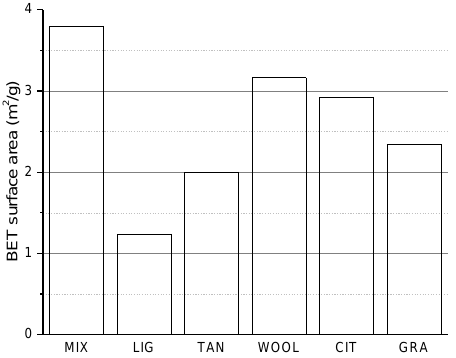
Figure 8. BET specific surface area for different samples.